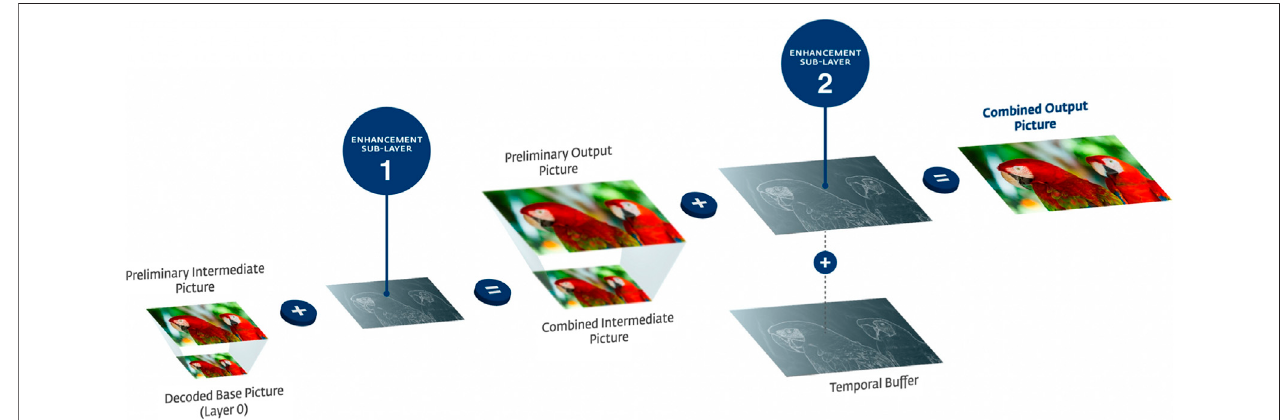
FIGURE 1 | LCEVC enhancement layers.